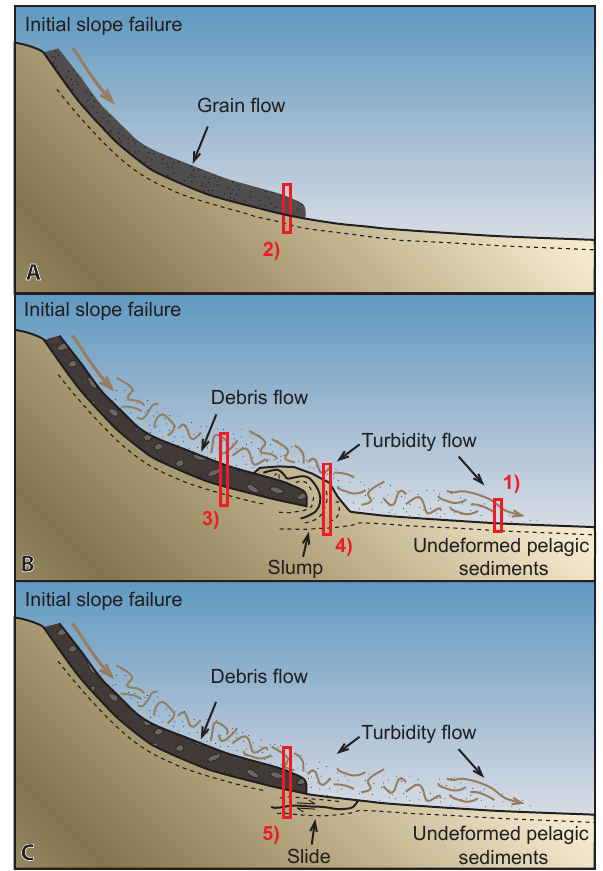
Fig. 8. Illustration of the evolution of mass movements in Lake El’gygytgyn. (A) Delta collapses of well-sorted material result in grain flows where the sediment density and grain size is too high to support turbulence. (B) Debris flow deforms pelagic sediments and creates co-generic turbidity current in front and on top of the debris flow. (C) Slide deposits encountered at the lake center may be caused by debris flows. Red rectangles indicate examples of the mass movement types (1) turbidite (Fig. 3), (2) grain-flow deposit (Fig. 4), (3) co-generic debrite-turbidite (Fig. 5), (4) slump (Fig. 6) and (5) slide-debrite (Fig.